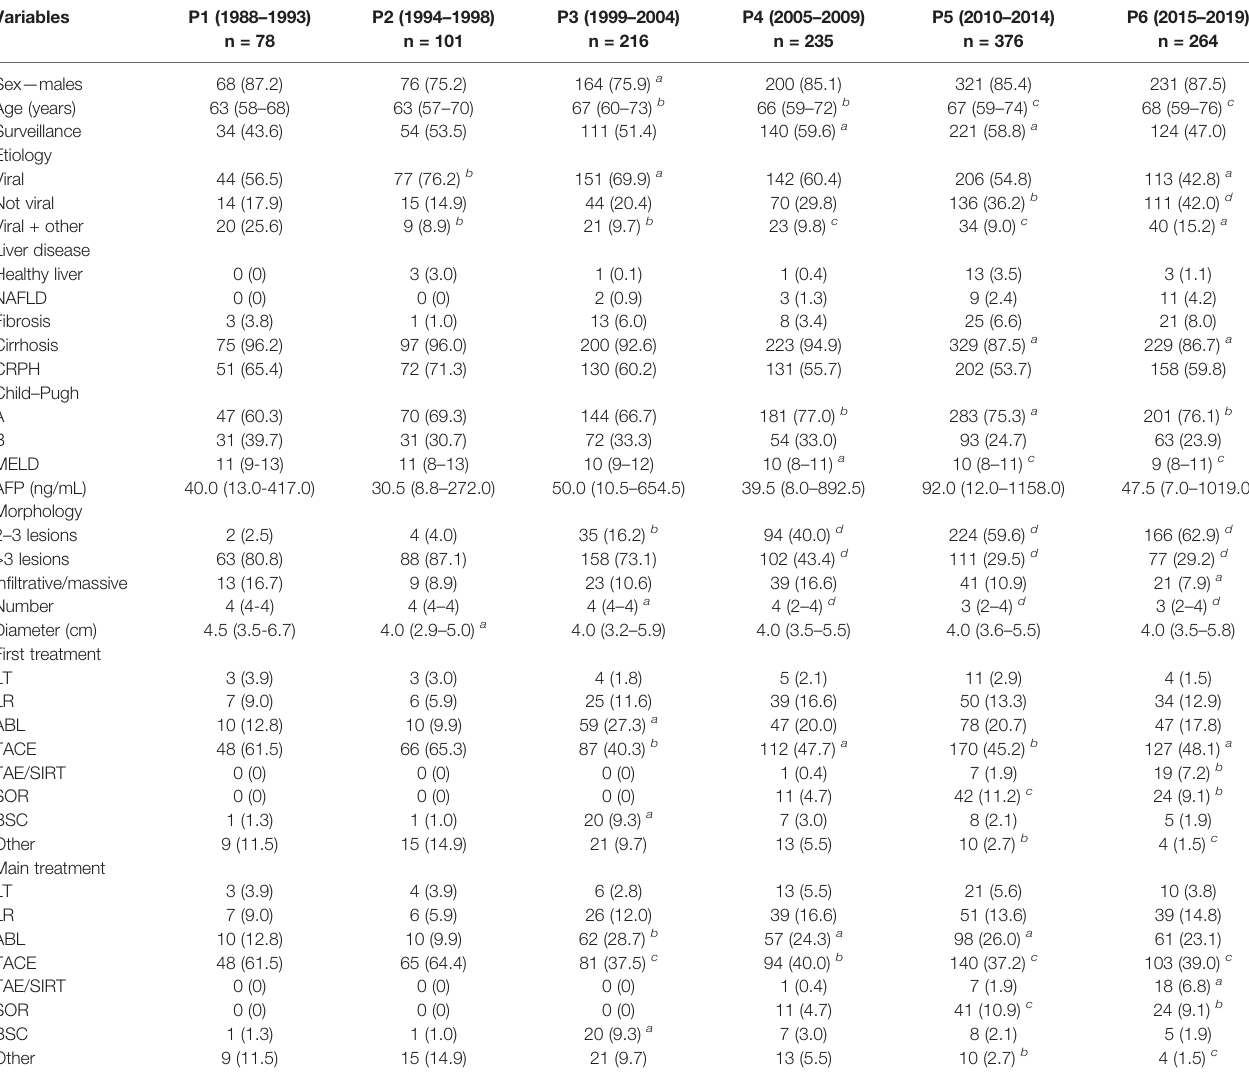
TABLE 2 | Baseline characteristics of the BCLC B patients divided according to the period of